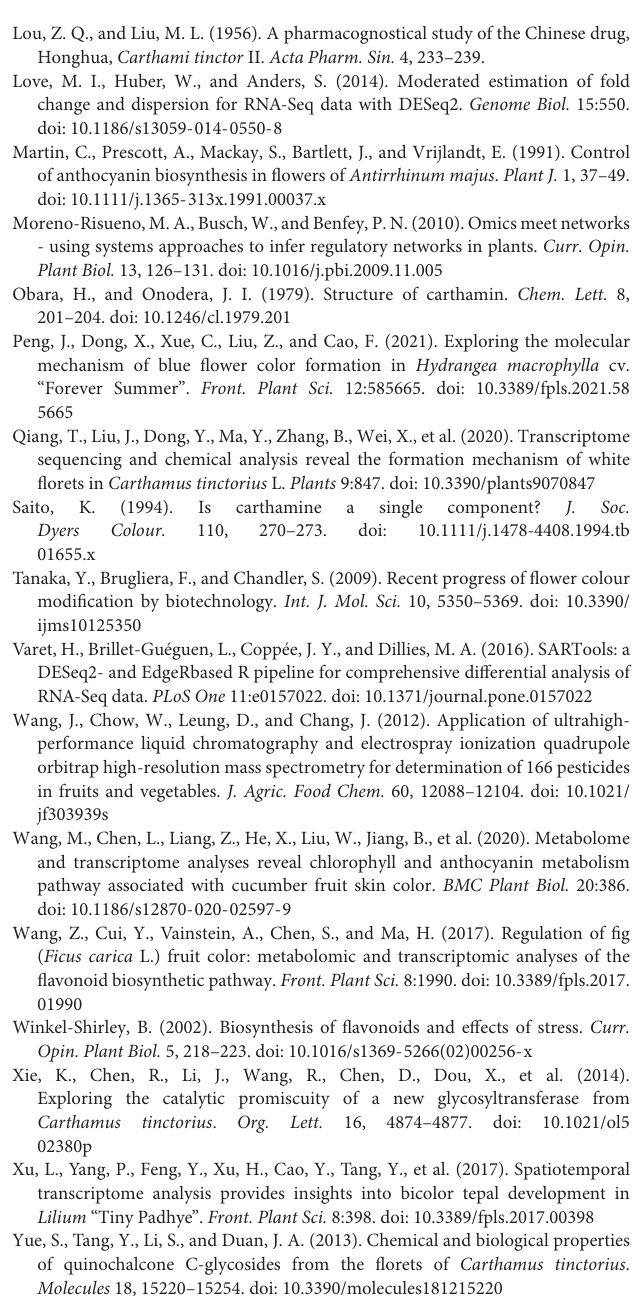
Supplementary Figure 1 | Validation of RNAseq by qPCR. (A) The RNA detection of the sample returned. (B) Gene expression from the RNAseq data (based on FPKM). (C) Gene expression from qPCR data (based on (cid:49) Ct method). Supplementary Figure 2 | Heatmap for the different types of flavonoids among the different color of safflower. W, white; Y, yellow, LR, light red; DR, deep red. Supplementary Table 1 | The raw data for the detected metabolic species in our manuscript. Supplementary Table 2 | Details of flavonoid metabolic species in four different color flowers of safflower.